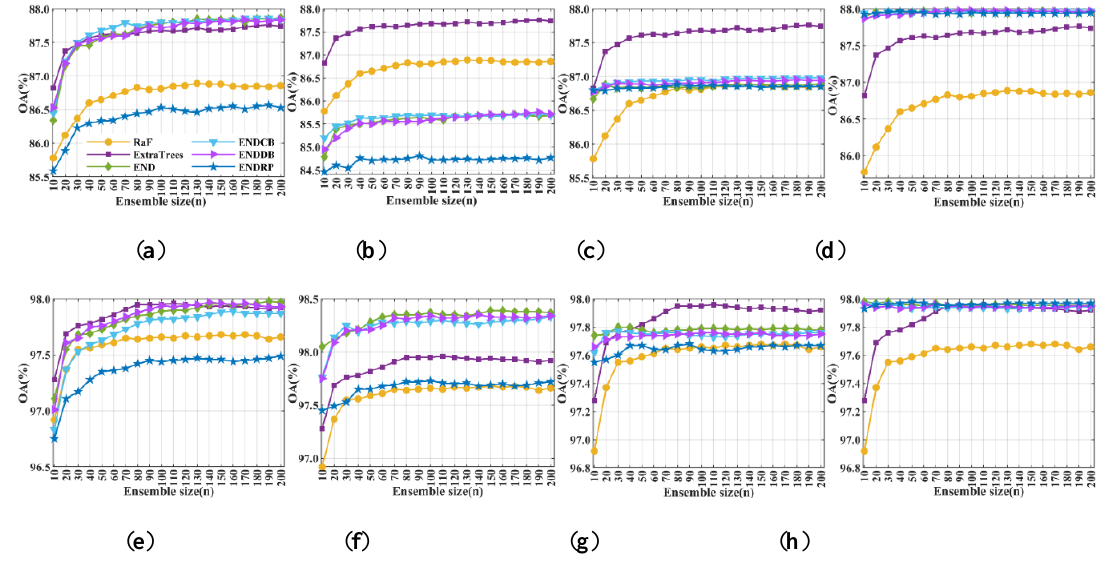
Figure 7. OA values versus the ensemble size of the END, ENDCB, ENDDB, and ENDRPS frameworks with ERDT ( a , e ), C4.5 ( b , f ), RaF ( c , g ), and ExtraTrees ( d , h ) classifiers while using the original raw bands ( a , b , c , d ) and the MPs ( e , f , g , h ).